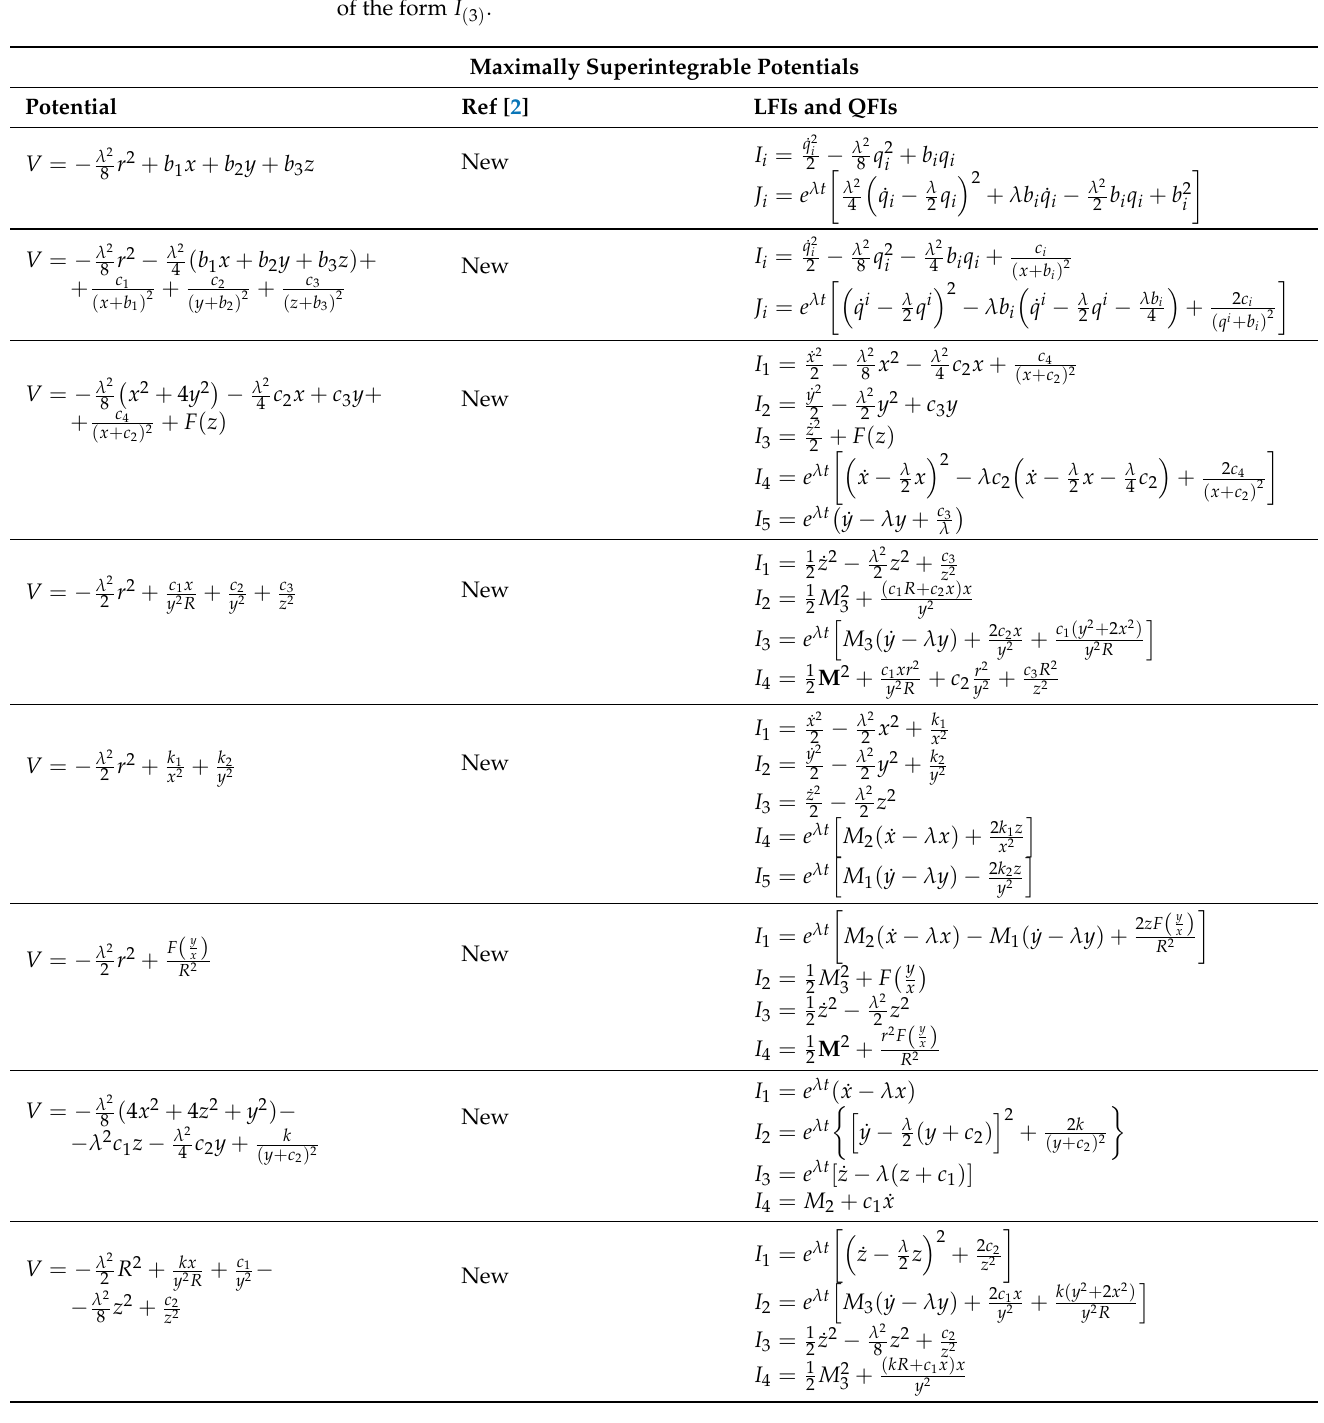
Table 13. Maximally superintegrable potentials V ( x , y , z ) in E 3 that admit time-dependent LFIs/QFIs of the form I ( 3 )